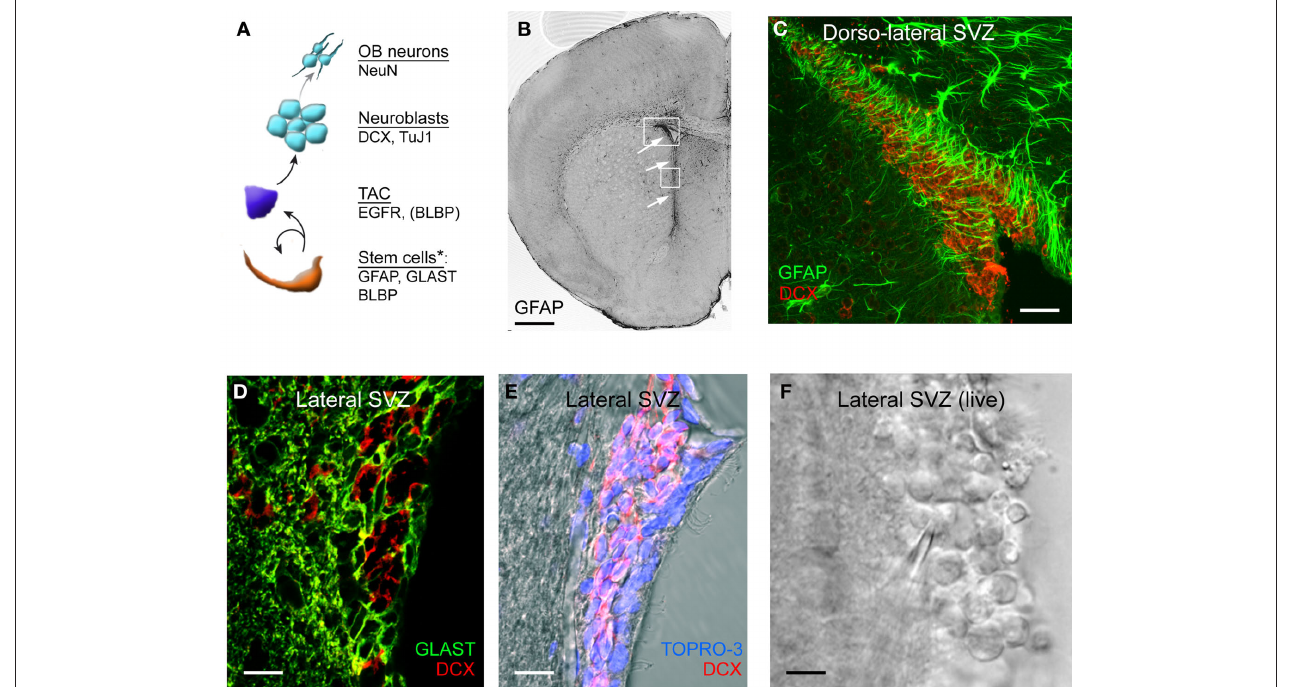
dorso-lateral SVZ. (D) Confocal image of GLAST (green) and DCX (red) co- immunostaining in the lateral SVZ located along the lateral ventricle (e) Confocal image of DCX (red) immunostaining and TOPRO-3 (nuclear labeling) in the lateral SVZ. (F) Image of a live coronal slice containing the lateral SVZ. The lateral ventricle is on the right and the striatum on the left. Scale bars: 500 μm (B) , 100 μm (C) , 60 μm (D) and (e) , 40 μm (F) . *Note that presumably all stem cells express these markers, but individual markers alone are not sufficient to identify stem